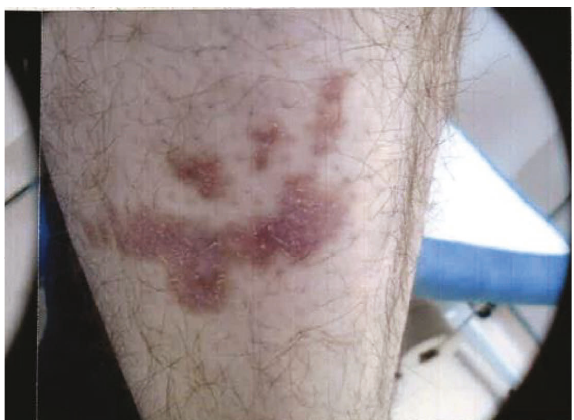
Figure 1: A 7 cm, irregular scaly pink, brown plaque of giant dermatofibroma with satellite lesions on the right shin of a young male. An asymptomatic and slow growing lesion which was nonulcerated.